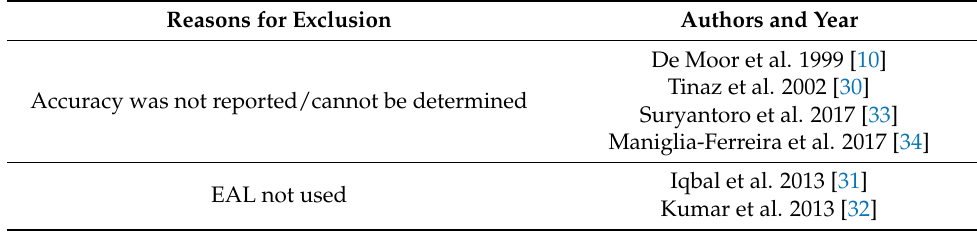
Table 1. Excluded studies and the respective reasons for each